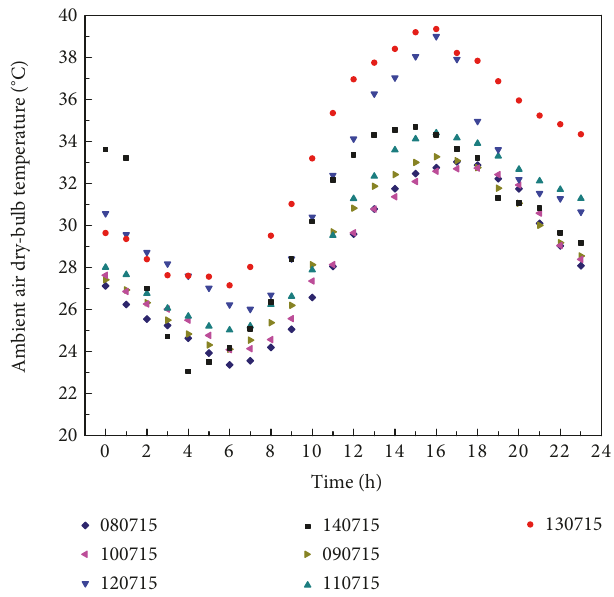
Figure 4: Ambient air dry-bulb temperature from 08 July 2015 to 14 July 2015.